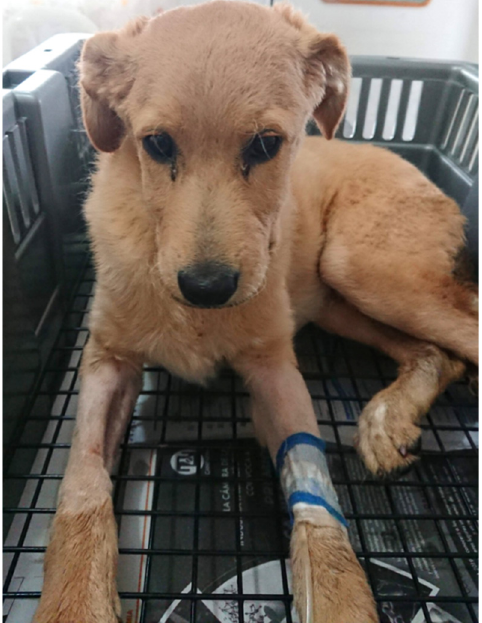
Figure 2. Characteristics of an infant-like, or paedomorphic face. A 3-month-old Golden Retriever puppy with gastrointestinal disease. The image shows the broad forehead and large eyes suggestive of sadness, two traits that may also be associated with chronic pain [39].